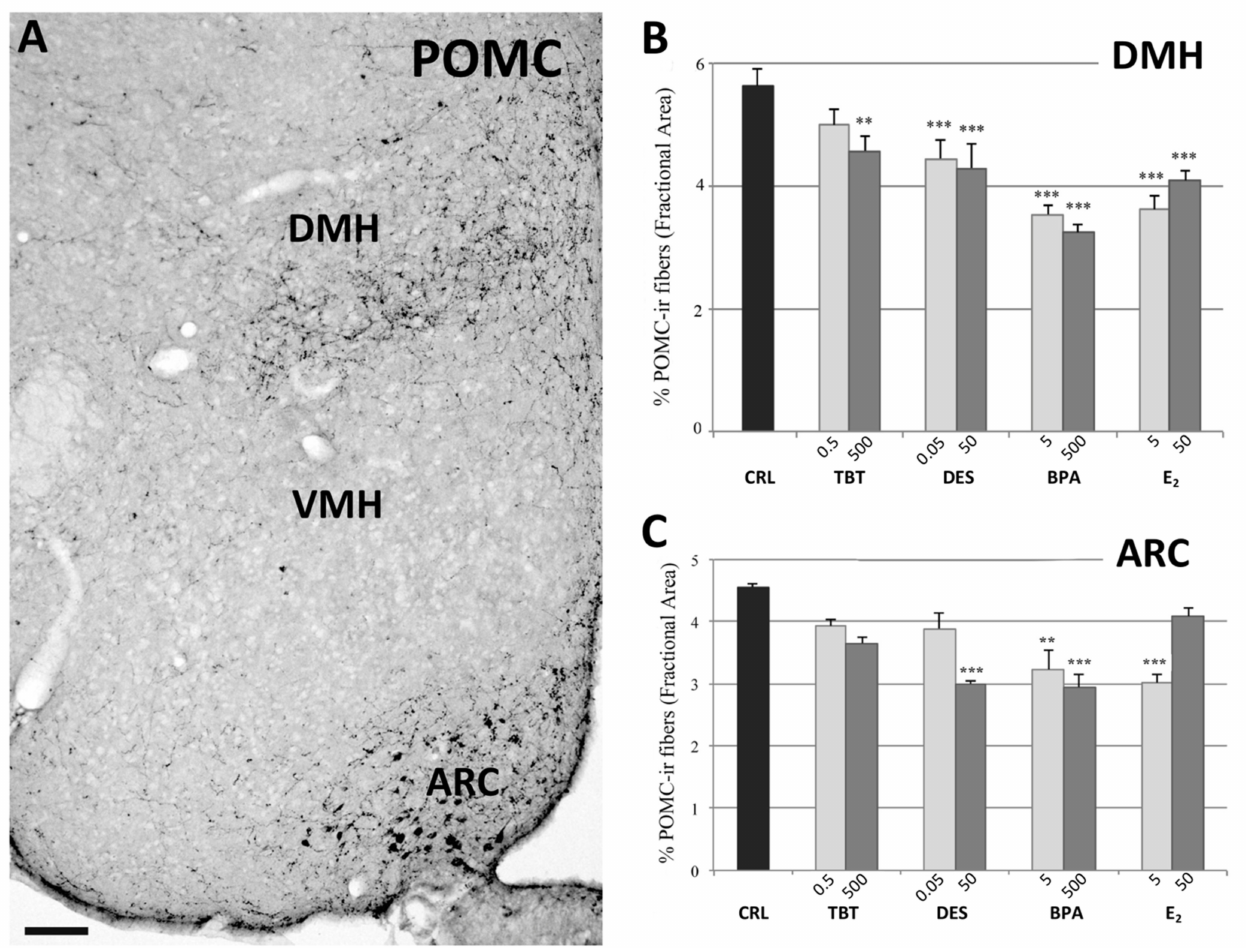
Figure 3. POMC immunohistochemistry. Microphotograph and histograms illustrating the immunohistochemical im- munoreactivity for POMC in the dorsomedial (DMH), and arcuate (ARC) nuclei. ( A ) Low magnification of the hypotha- lamic region of a control mouse (CRL) illustrating the POMC immunoreactivity in DMH, and ARC nuclei. Due to the extreme paucity of immunoreactive structures, it was not possible to measure POMC immunoreactivity in the VMH. Scale bar = 100 µ m. ( B , C ) Histograms illustrating the quantitative analysis of the fractional area covered by POMC im- munoreactivity in the DMH (B), and ARC (C) nuclei in the different experimental groups. Bars represent the mean and the standard error of the mean (SEM). Asterisks indicate significant differences (Fisher’s test) of the experimental groups in comparison to controls (CRL): ** p < 0.01, *** p <